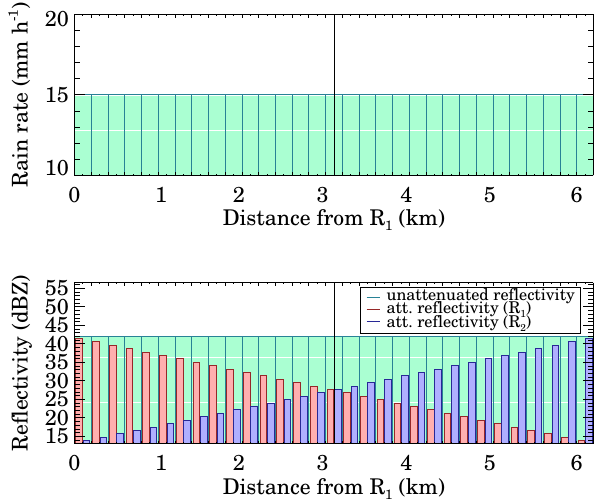
0 Figure 2. Idealised synthetic data simulated along the measuring path. Homogeneous precipitation pattern with a rainfall intensity of 15mmh − 1 (top panel) and corresponding reflectivity fields simu- lated using forward operator (bottom panel). Intrinsic reflectivity is shown in green and simulated, attenuated reflectivity in red for R 1 and blue for R 2 . The vertical black line marks the position of R 3